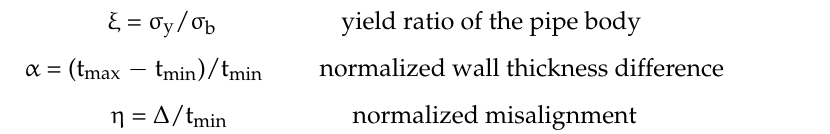
Figure 15. Mismatch and toughness effects on TSC 12.8 mm — 12.8 mm WT.